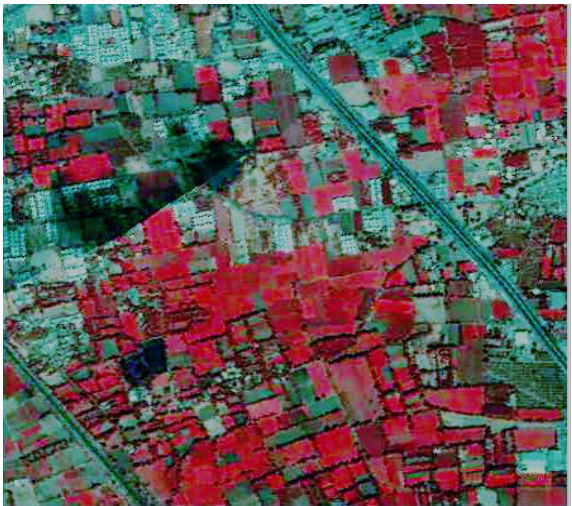
Figure 7. Original False Color Composite(FCC) image